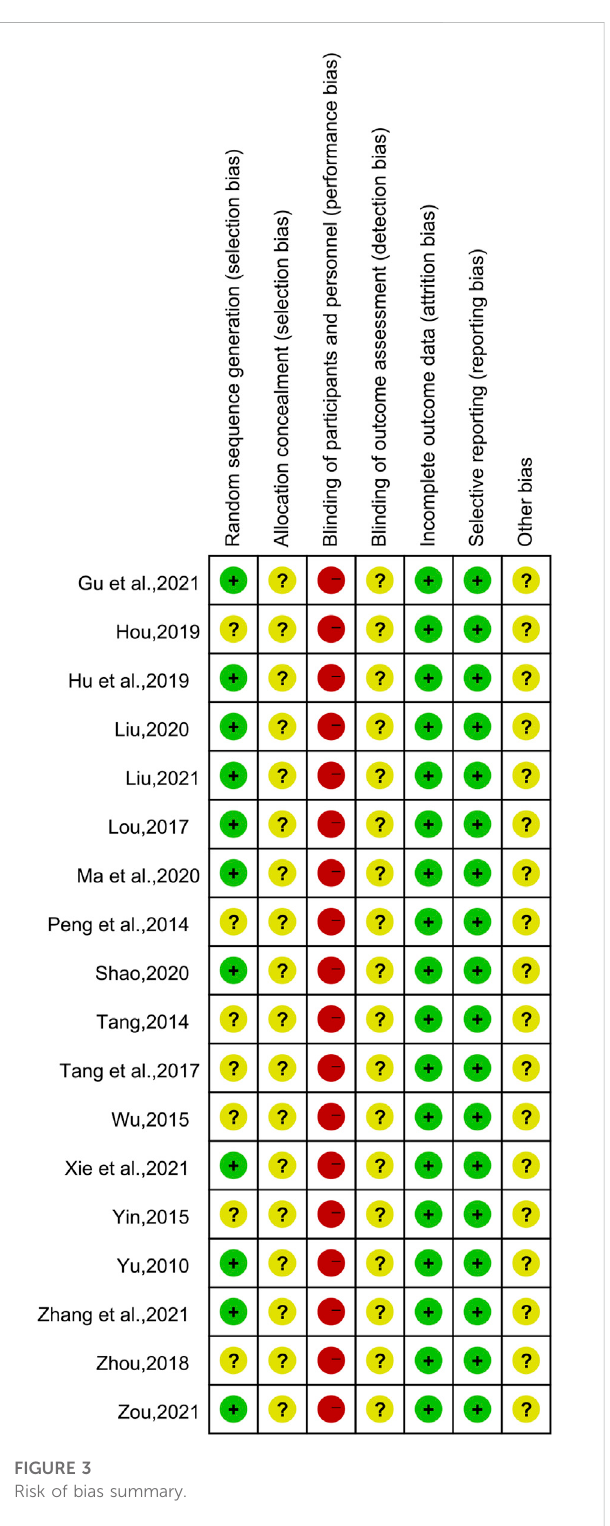
FIGURE 3 Risk of bias